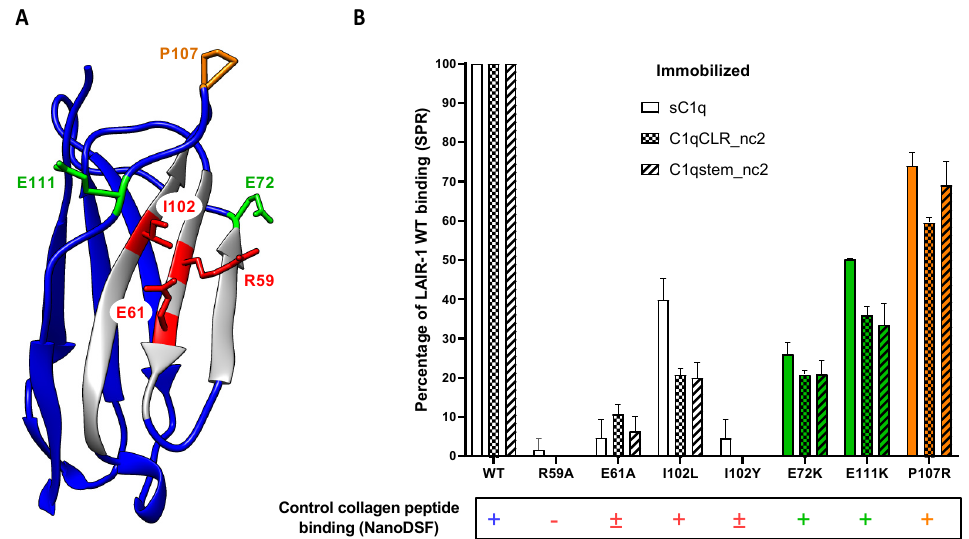
Figure 7. Mutational analysis of LAIR-1 interaction with C1q. ( A ) Crystal structure of LAIR-1 Ig-like domain (PDB code: 3KGR). The side chains of the mutated residues are shown and labeled. The central binding residues are colored in red and the distal residues are shown in green and orange (as in Figure 5). ( B ) SPR measurements of the interaction of LAIR-1 WT and mutants with sC1q, C1qCLR_nc2 and C1qstem_nc2. Results are expressed as the percentage of the LAIR-1 WT response and error bars represent the SD of three different experiments. The detection of a binding signal of LAIR-1 variants with the positive collagen peptide control measured with the nanoDSF method is reported at the bottom. The presence or absence of the characteristic binding signal is reported with + or − symbols, respectively. The cases where a weak binding signal remains are indicated with a ± symbol. The raw data of the peptide interactions are presented in Figures 5B and S5.